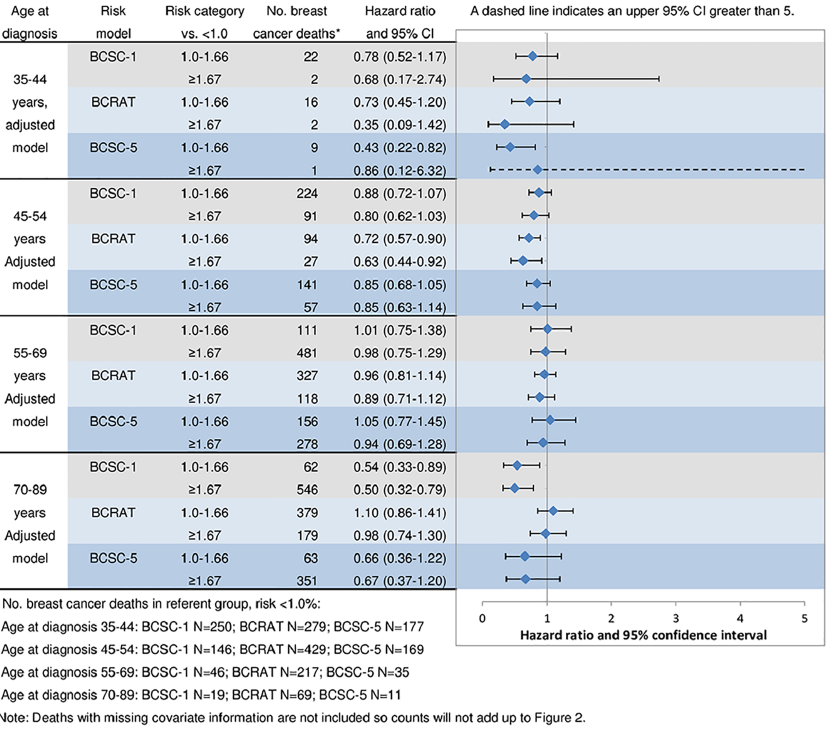
Fig 4. Predicted risk of developing breast cancer versus risk of death (age-stratified, adjusted models). Age-stratified models, adjusted for age in single years, registry, year of diagnosis, mode of detection, AJCC stage, treatment (surgery and chemotherapy: yes/no) and income (zip code of